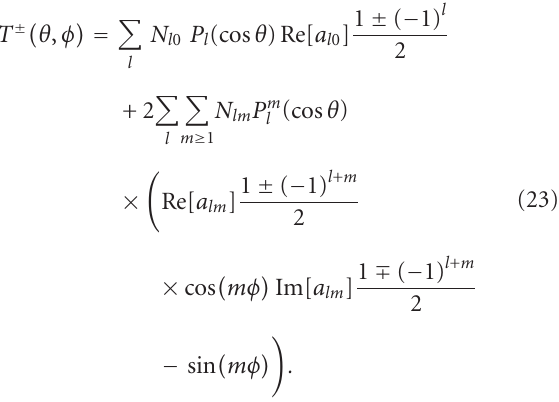
Figure 13: The parameters R − ( l ) (top panel, the black line) for odd multipoles and R + ( l ) (top panel, the red line) for even multipoles. The black dash line is the asymptotic R + ( l = even) = 0 . 5, the blue dash line is for R − ( l = odd) = ( l − 1) / 2( l −